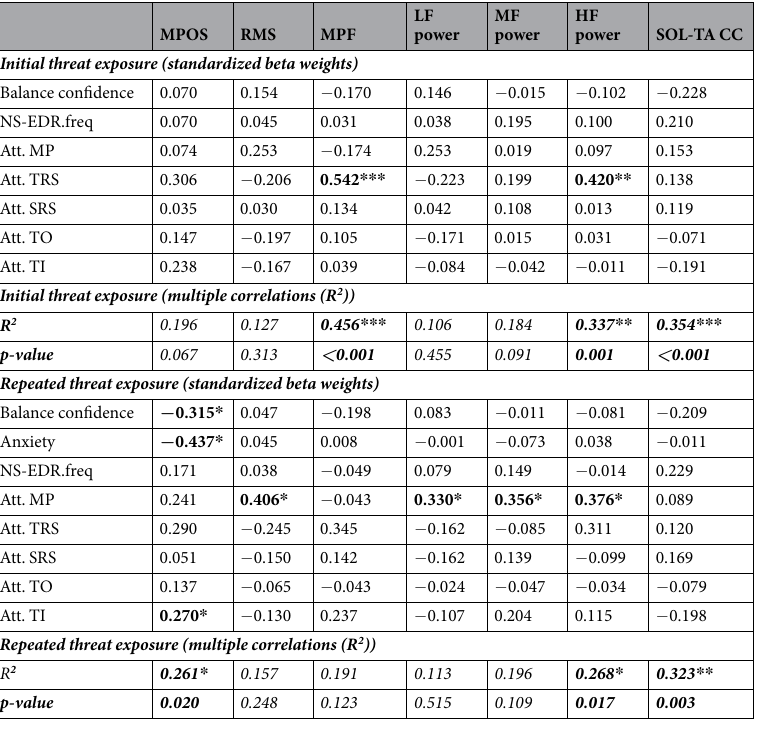
Table 2. Multiple correlations (R 2 ) and standardized beta weights for regressions between changes in emotional and cognitive state measures and behavioural measures. Note . Independent and dependent variables reflect change scores (Initial threat exposure = HIGH1-LOW1; Repeated threat exposure = HIGH5-HIGH1). NS-EDR.freq = non-specific electrodermal response frequency; Att. = attention toward; MP = movement processes; TRS = threat-related stimuli; SRS = self-regulatory strategies; TO = task objectives; TI = task- irrelevant information; MPOS = mean position of centre of pressure; RMS = root mean square of centre of pressure; MPF = mean power frequency of centre of pressure; LF power = low frequency centre of pressure power; MF power = medium frequency centre of pressure power; HF power = high frequency centre of pressure power; SOL-TA CC = soleus-tibialis anterior co-contraction. * p < 0.05; ** p < 0.01; *** p < 0.001 ; significant β ’s and R 2 ’s are